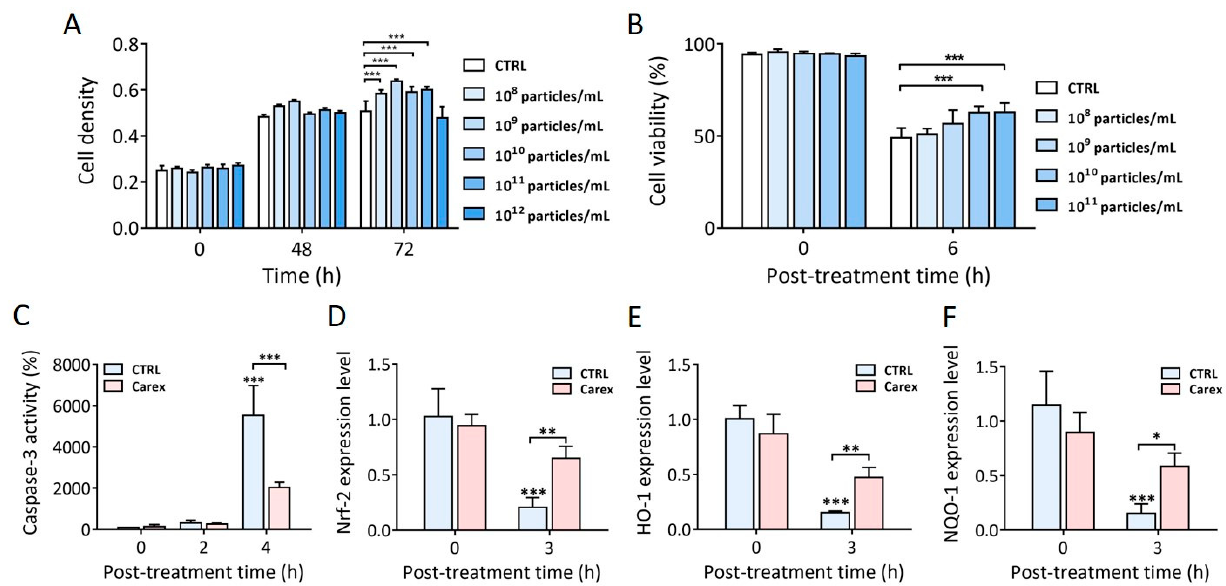
Figure 5. Antioxidative and apoptotic effect of Carex in human neuroblastoma SH-SY5Y cells. ( A ) Carex dose-dependent effect on cell densities and its cytotoxicity was measured. ( B ) Anti-apoptotic effect of Carex in SH-SY5Y cells treated with 6-OHDA using WST-1 assay. ( C ) Inhibition of caspase-3 activity in SH-SY5Y cells supplemented with 1 × 10 11 particles/mL of Carex. ( D – F ) RT-PCR analysis of Nrf-2 ( D ), HO-1 ( E ), and NQO-1 ( F ) mRNA expression levels in SH-SY5Y cells treated with 6-OHDA. All values are expressed as mean ± SD (* p < 0.05, ** p < 0.01, *** p < 0.001; n = 3).